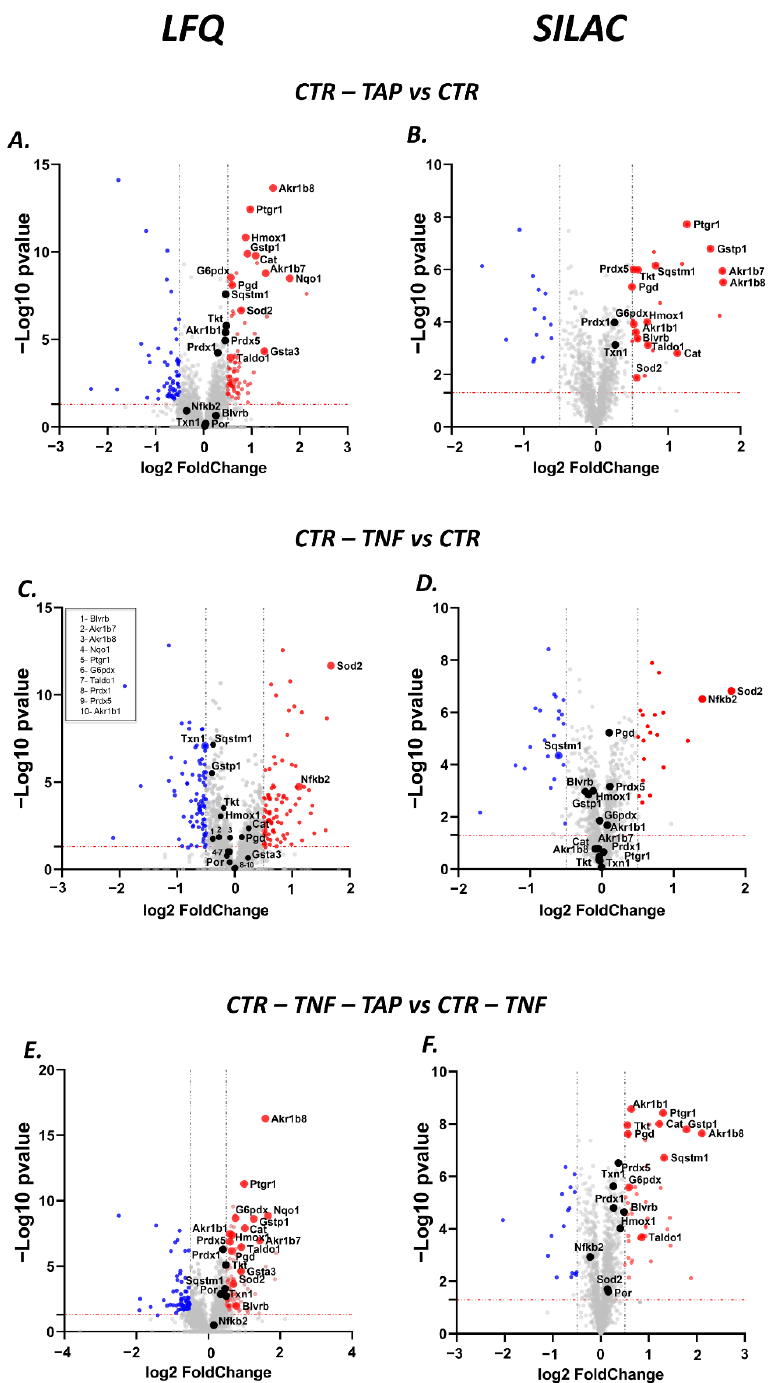
Figure 5. Volcano plot of the LFQ and SILAC analyses. The two columns represent the LFQ (left) or SILAC (right) analyses. In the first row, the two volcano plots ( A , B ) illustrate the analyses performed to understand the impact of TAP extract on the cell proteome. On the second row, ( C , D ) show the volcano plot for the comparative condition achieved by treating cells with TNF α . Lastly, ( E , F ) are the volcano plots showing the differential proteome expression for the inflamed cells treated with TAP extract. In each volcano plot, the most representative proteins identified in the various analyses are labeled in red if up-regulated ( p value < 0.05, log2 Fold-change > 0.5), in blue if down-regulated ( p value < 0.05, log2 Fold-change < − 0.5) and in black when they do not fall into the two aforementioned conditions. A more comprehensive analysis of the log2 Fold-change values is available in Table